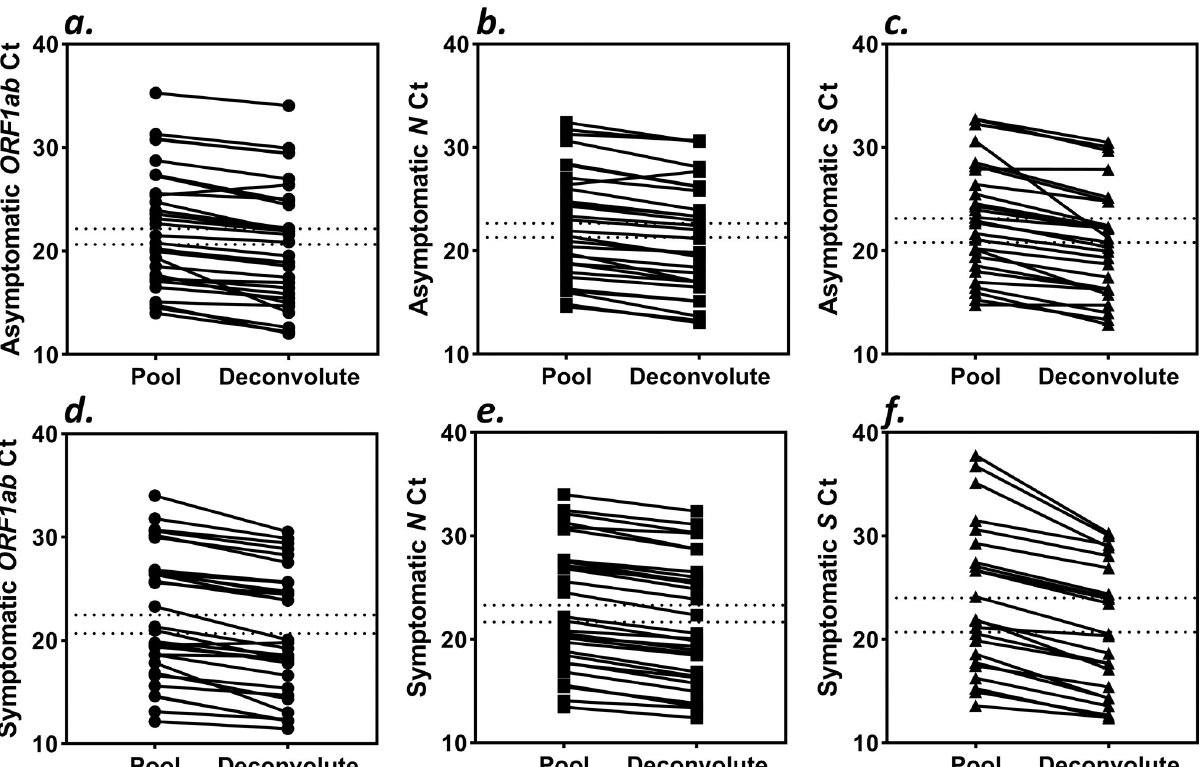
Fig 1. Trend of C t shift from pooled and deconvoluted result. Pairwise comparisons of pooled and deconvoluted samples for each SARS-CoV-2 gene target from Asymptomatic ( a , b , c )and Symptomatic cohorts ( d , e , f );ORF1ab, circles; N gene, squares; S gene, triangles; mean C t values, dashed